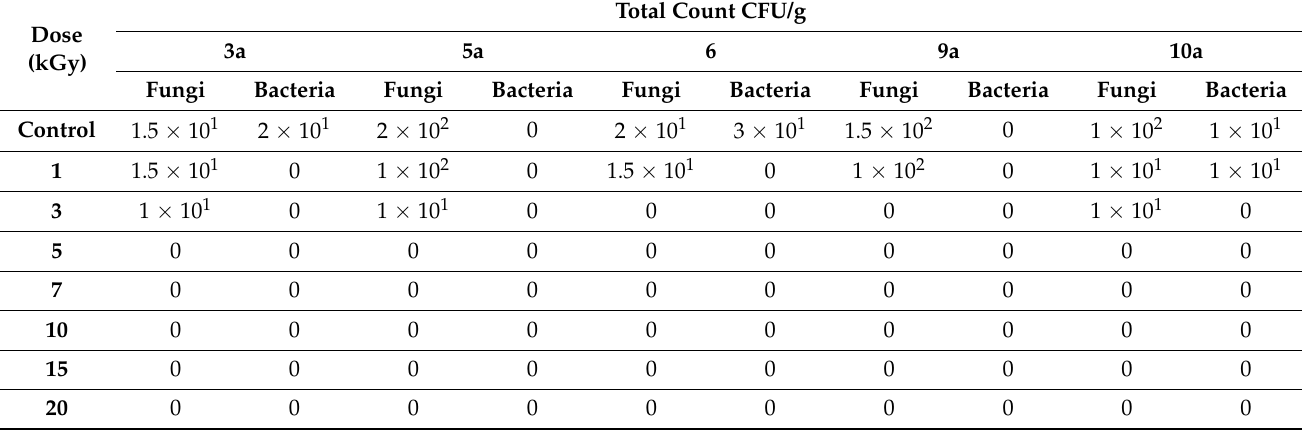
Table 5. The microbial count (CFU/g) of the nonirradiated and irradiated pyrazole and pyrazolo[1,5- a ]pyrimidine